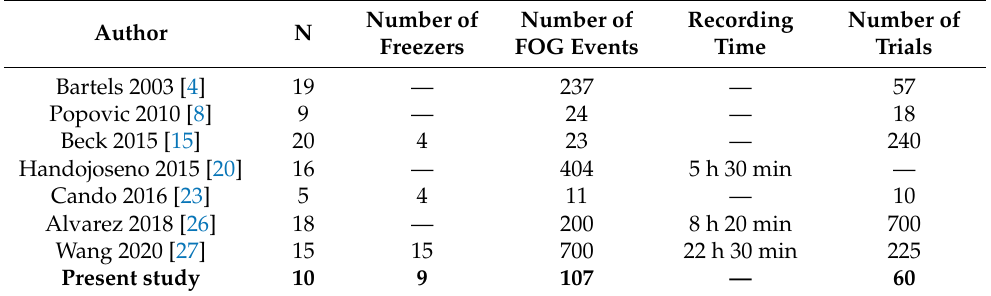
Table 7. Number of FOG episodes triggered by each experiment during OFF medication state.